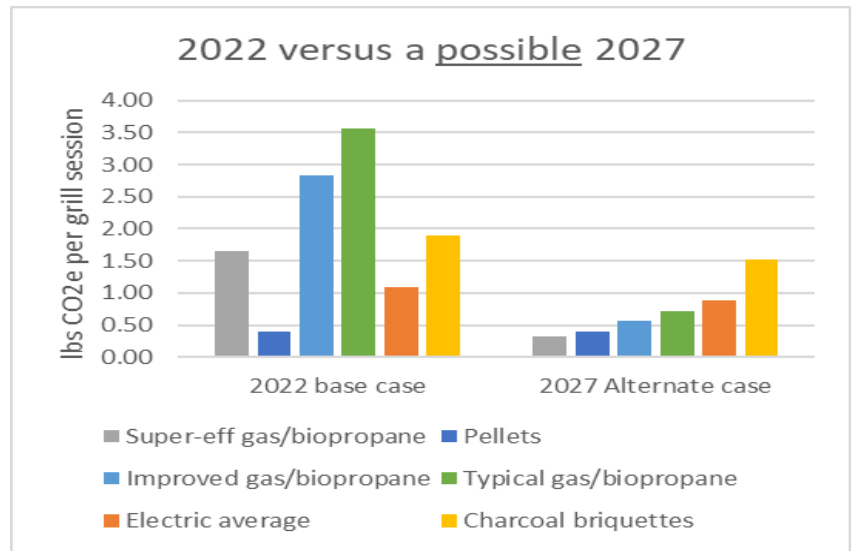
10 Figure 4. Grill-specific carbon footprints for grills, with high-low-average electricity, USA 2022. 4.2. Footprints 2027